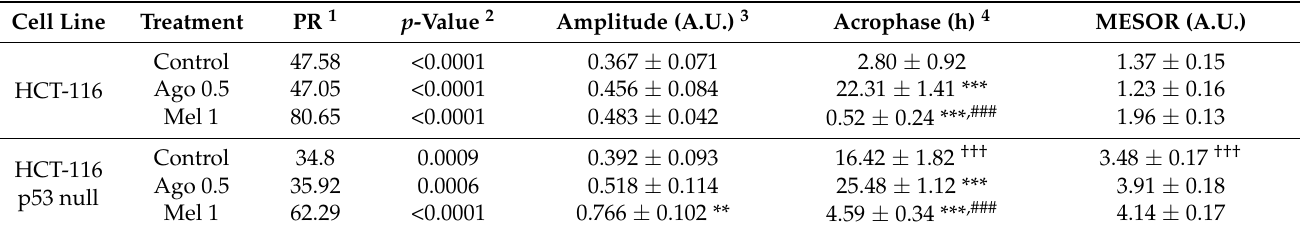
Table 3. Results of the cosinor analysis of Sirt1-gene expression after agomelatine or melatonin treatment in the HCT-116 and HCT-116-p53-null cell lines.